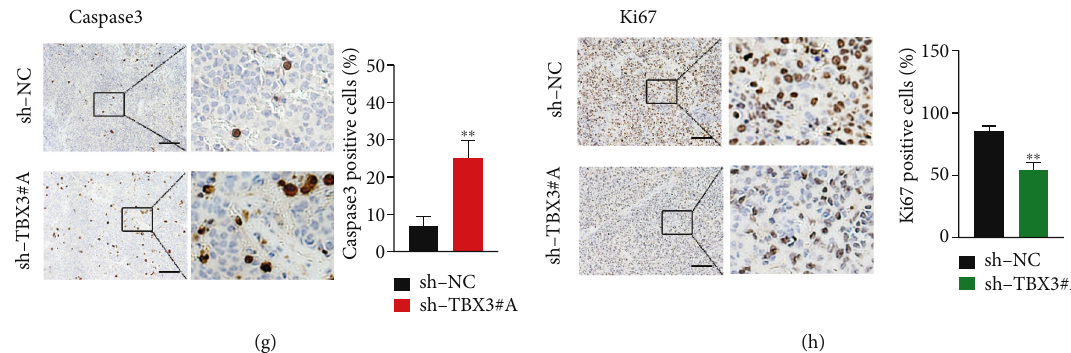
Figure 8: sh-TBX3 exhibits tumor growth inhibition e ff ect in xenograft tumor model. (a) Flow chart of the xenograft tumor model. (b) Tumor signal values in nude mice. (c) Measurement of tumor size in control and experimental groups. (d) Statistics of the average weight of the two groups of tumors. (e) Tumor growth curves of experimental group and control group. (f – h) Immunohistochemistry of TBX3, Ki67, and Caspase3. Scale bars: 100 μ m. Each sh-TBX3 group was compared with the sh-NC group. ∗ p < 0 : 05 , ∗∗ p < 0 : 01 , ∗∗∗ p < 0 : 001 ; ns: not signi fi